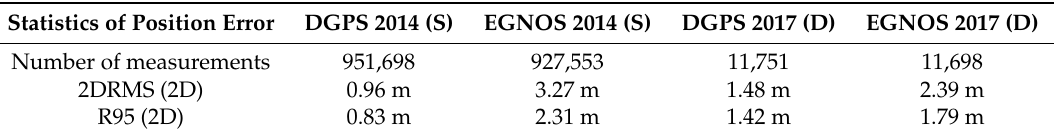
Table 1. Statistics for the DGPS and EGNOS systems’ predicted position errors during the course of the stationary (S) and dynamic (D) measurement campaigns [35].